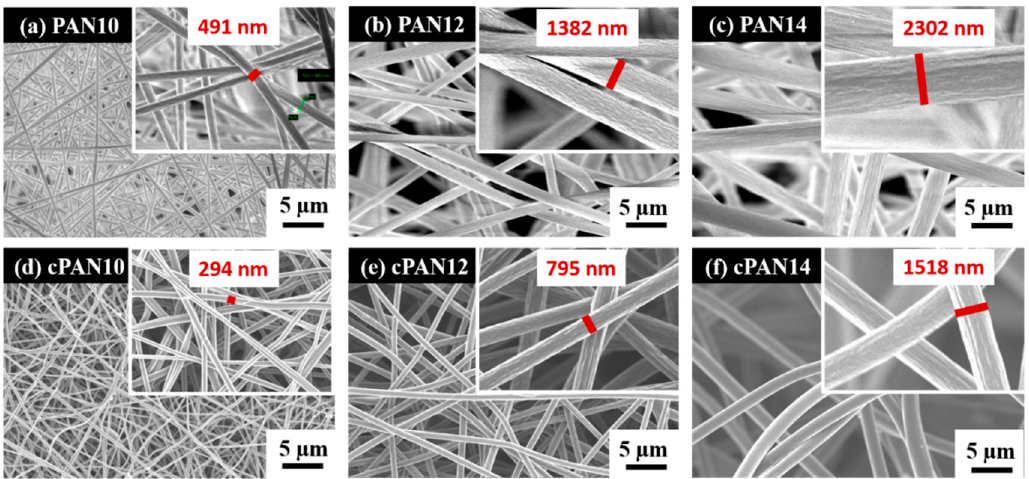
Figure 2. SEM images of ( a ) PAN10, ( b ) PAN12, ( c ) PAN14 and carbonized PAN nanofibers at 800 °C ( d ) cPAN10, ( e ) cPAN12 and ( f ) cPAN14.